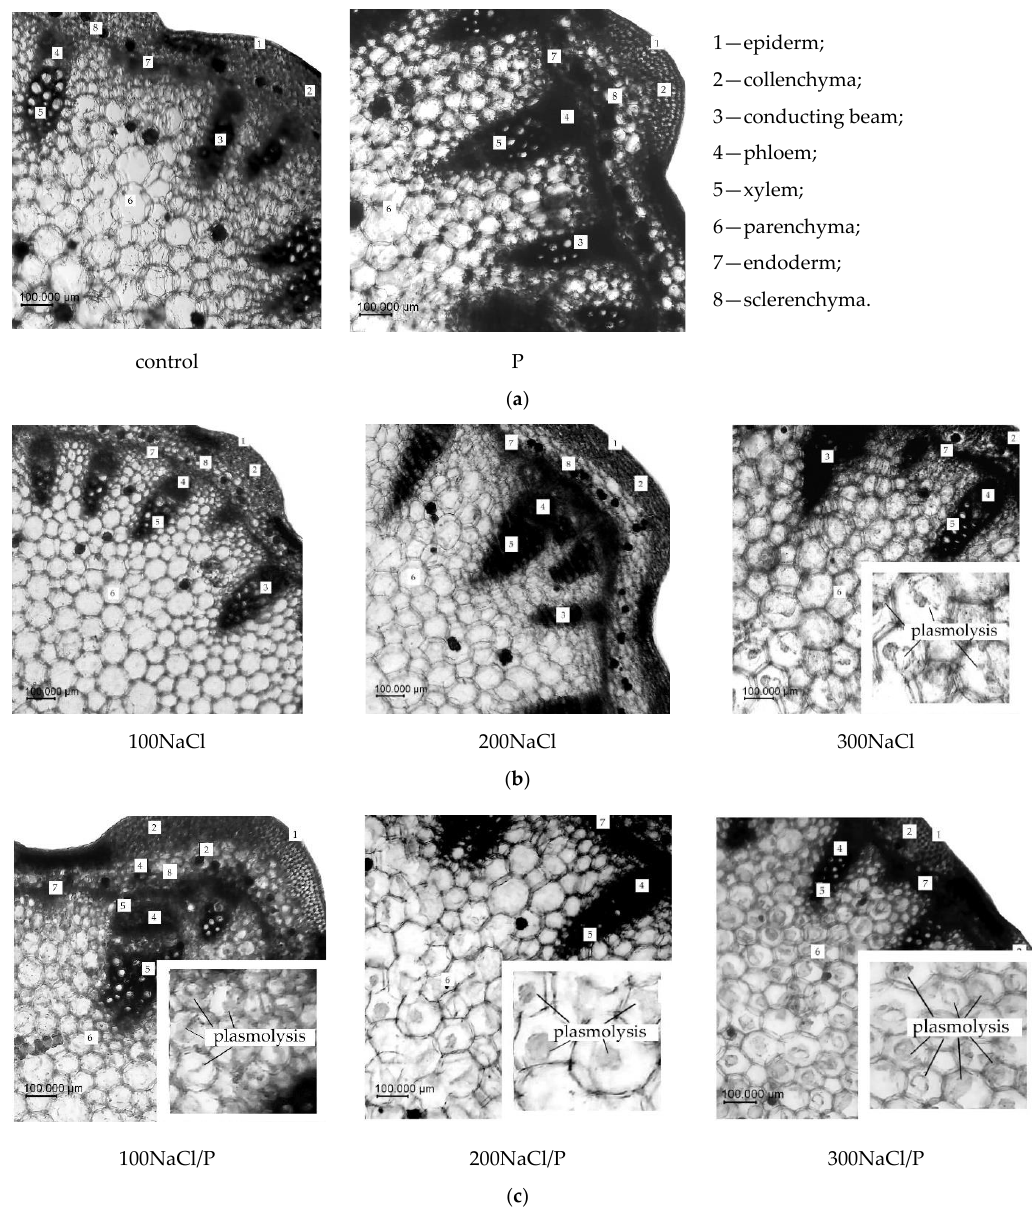
Figure 7. Stem cross-sections of Chenopodium quinoa exposed to abiotic stress of varying intensity: ( a ) osmotic stress; ( b ) salt stress; ( c ) combined